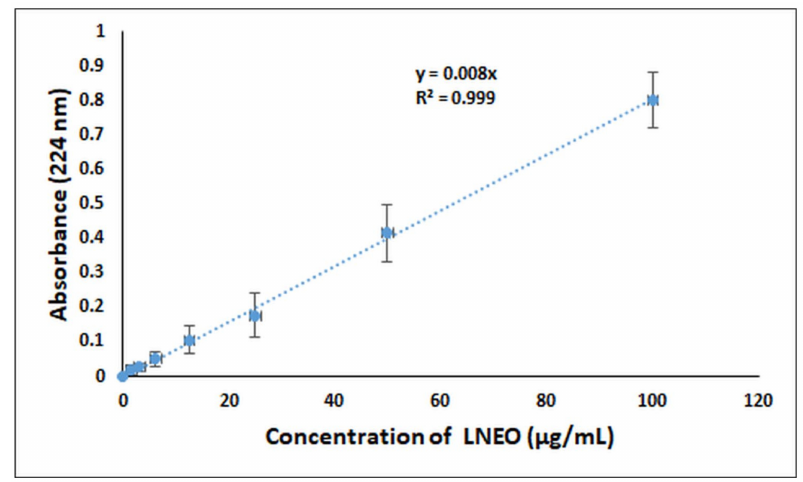
Figure 4. Standard curve of the LNEO.